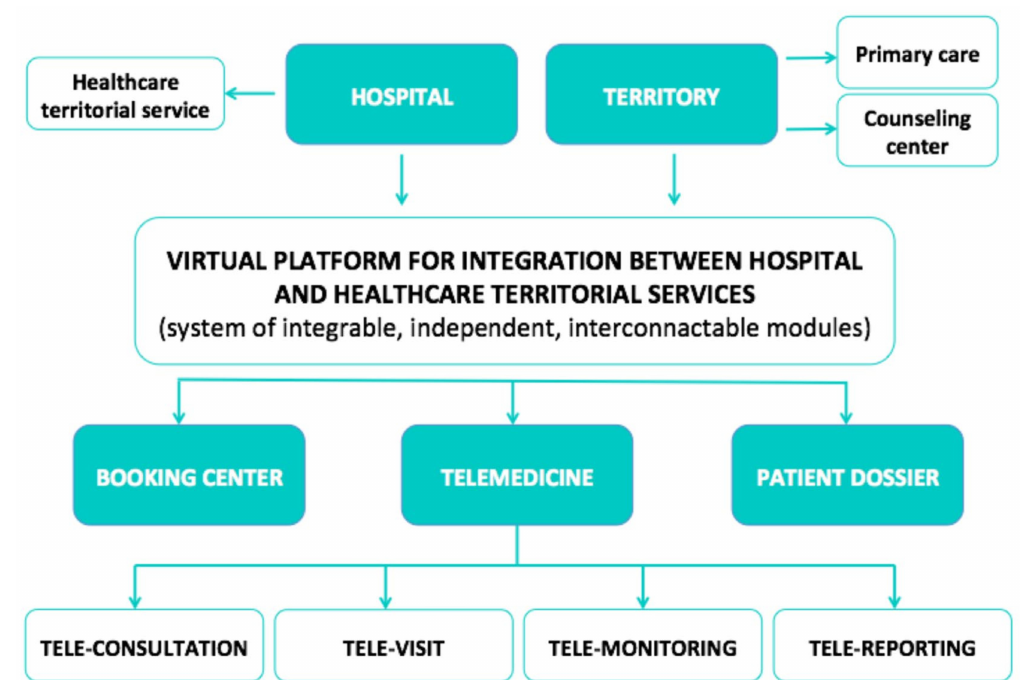
Figure 2. Overview of the COD 20 system: virtual platform for integration between hospital and healthcare services, reported by Zuccotti et al. [25] (created with BioRender.com, accessed on 16 October